Question: State the chart type depicted above.
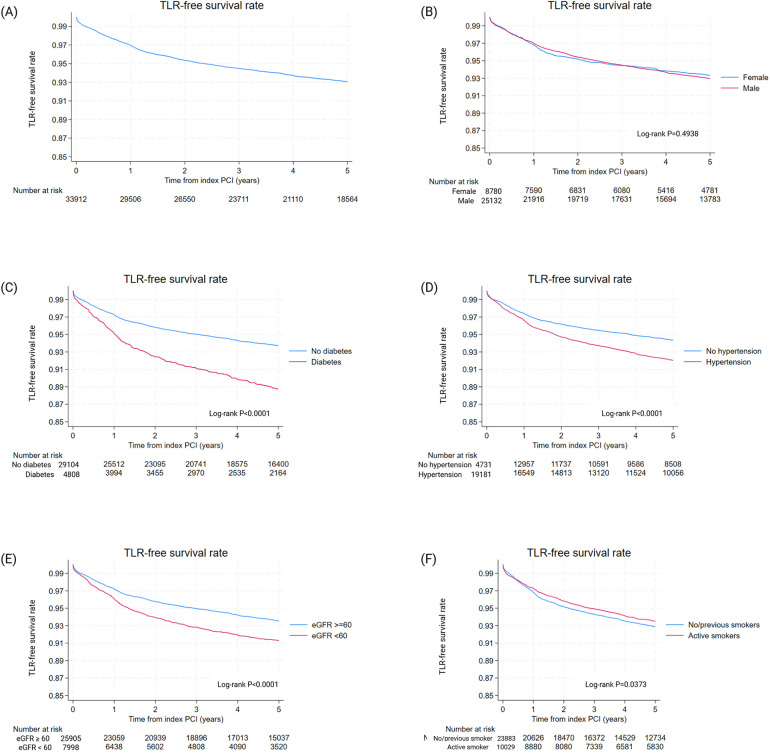
Answer: survival